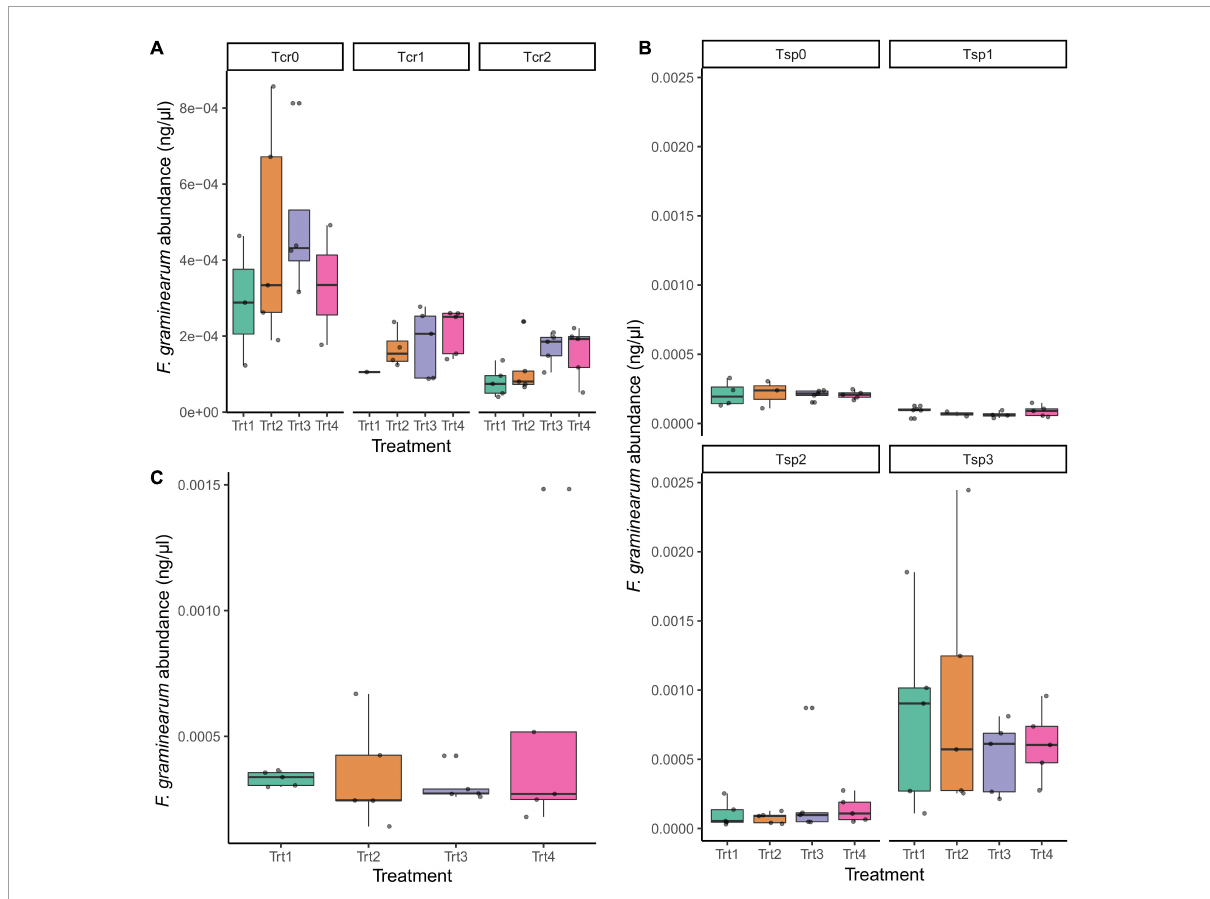
FIGURE4 The impact of T6085 application on F. graminearum abundance, as measured by quantitative PCR, in (A) crop residue; (B) wheat spikes; (C) wheat kernels. See text for a complete description of the sampling time points (T cr 0, T cr 1, T cr 2; T sp 0, T sp 1, T sp 2, T sp 3). The x -axis labels indicate the experimental treatments: Trt1 (non-inoculated control), Trt2 (T6085 applied to spikes at anthesis), Trt3 (T6085 applied to crop residue), Trt4 (T6085 applied to both spikes and to crop residue). Box plots indicate the 1st quartile, median and 3rd quartile. Within panels, there were no statistically significant differences among treatments (log-transformed F. graminearum abundances modeled on treatment, time point, the interaction between treatment and time point, and the blocking factor in the experimental design; p > 0.05 for treatment factor in all cases).